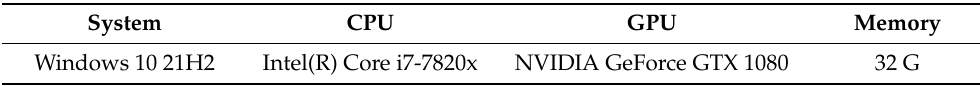
Table 3. Training platform configuration.